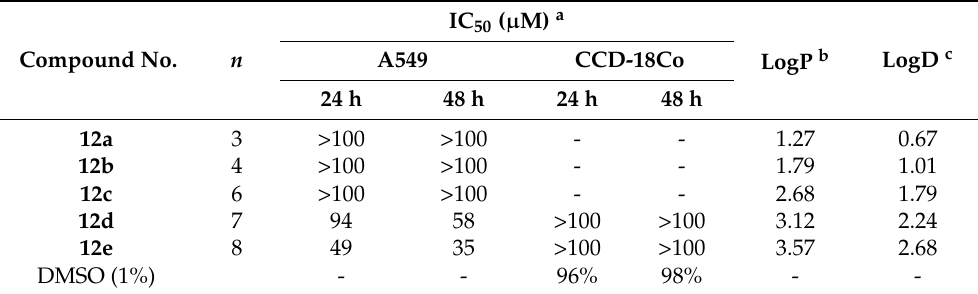
Table 2. IC 50 values of derivatives 12a – e in A549 cancer cell line and CCD-18Co fibroblasts.